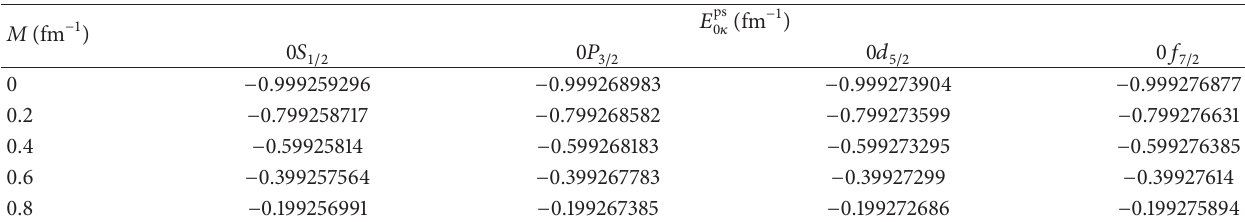
= −0.5 , 𝑎 = −0.02 , 𝑏 = 0.01 , and 𝐶 ps ps ps